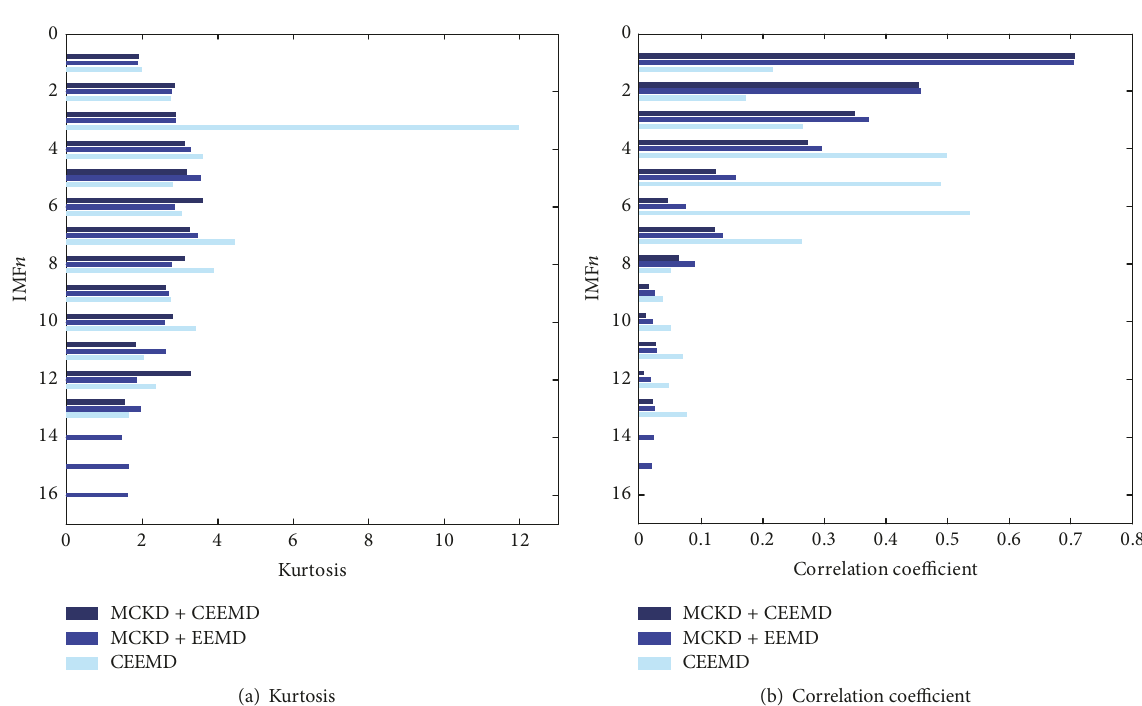
Figure 11: Characteristic parameters of Stage